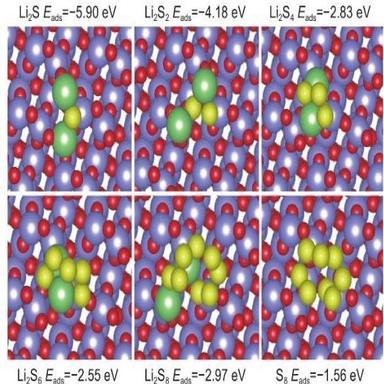
ptimized structure and binding energies between the (011) plane of MoO2 and Li2Sx.